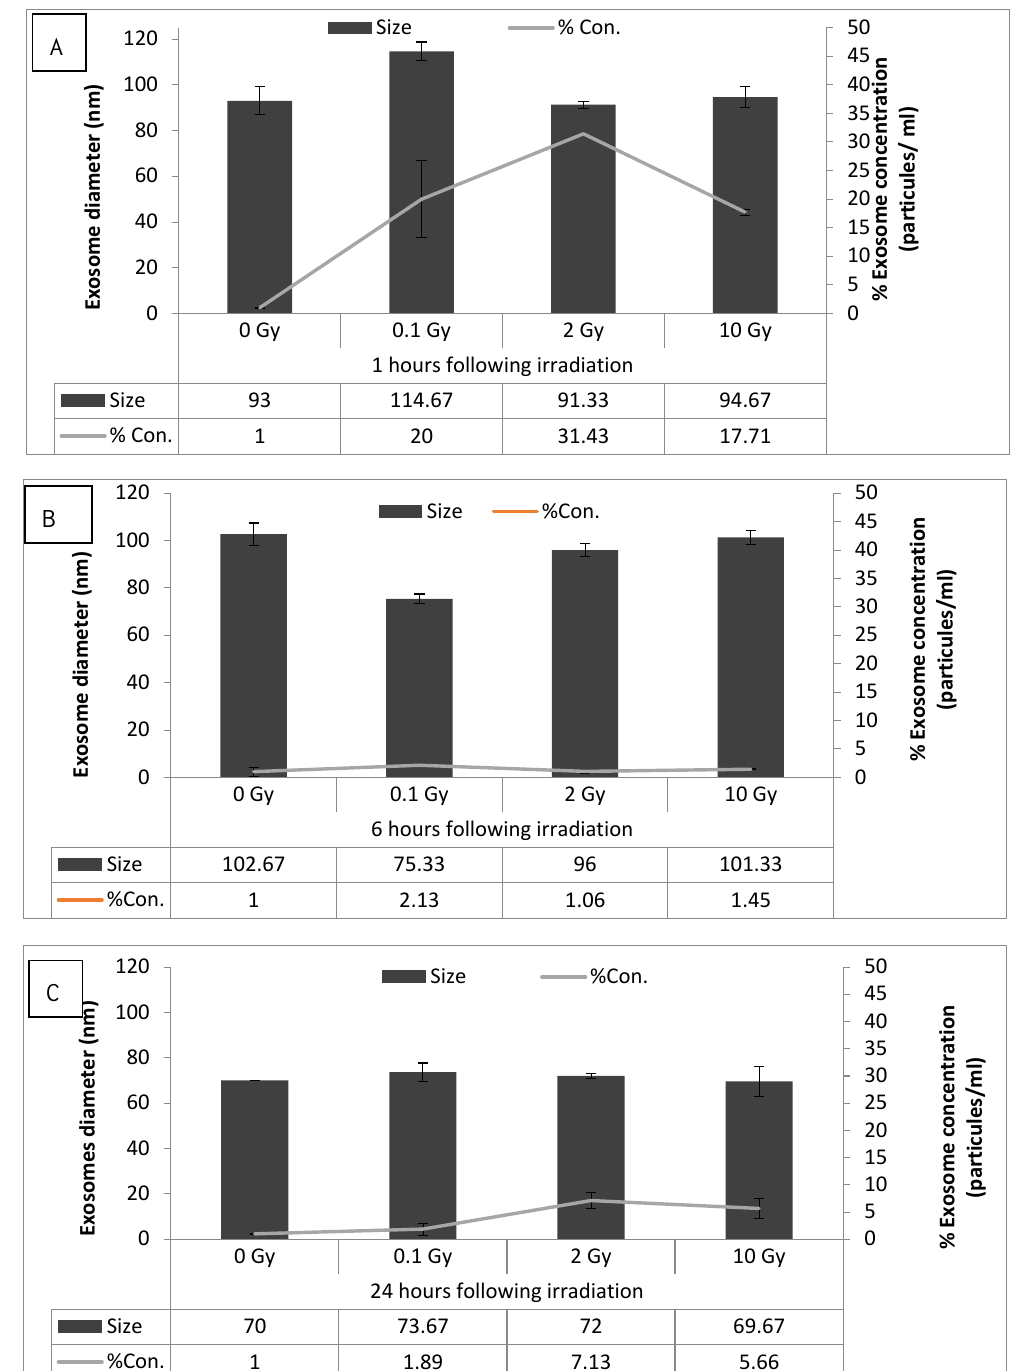
Figure 4. Panels ( A – C ) show exosome diameter and the concentration of exosomes at 1, 6, and 24 h after irradiation with doses of 0, 0.1, 2, and 10 Gy. The highest yield of exosomes was observed 24 h following irradiation for all dose points. Therefore, the 24 h time point was chosen for exosome extraction for use in experiments. The exosome concentration data was normalized to the corresponding control for each time endpoint.